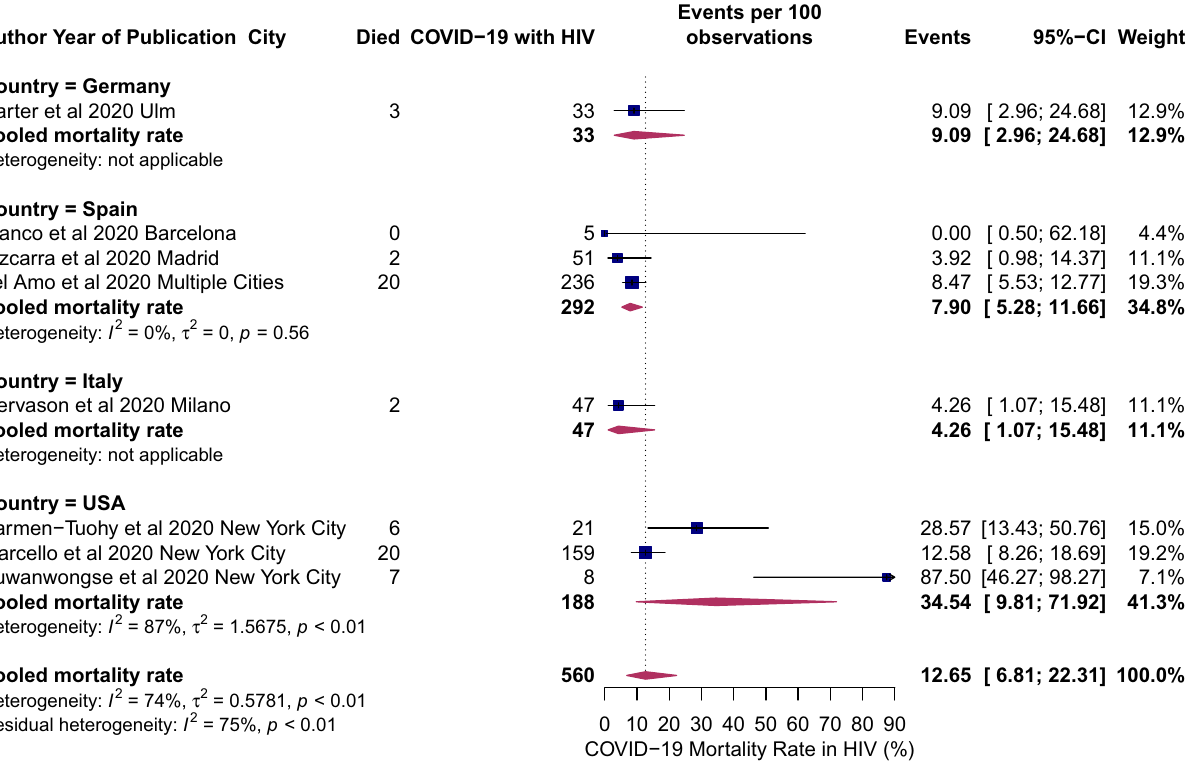
Figure 6. Mortality rates in COVID-19 individuals living with HIV/AIDS: mortality rates in HIV patients hospitalized COVID-19 stratified by country. Blue squares and their corresponding lines are the point estimates and 95% confidence intervals per each study. Maroon diamond represents the pooled effect